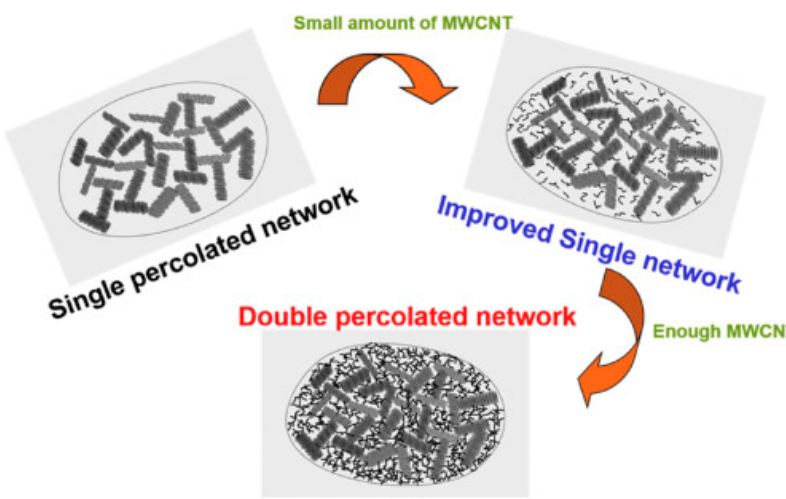
Figure 19. Schematic diagram of dual percolation network constructed by the cooperation of EG and MWCNT in the matrix. Follow the direction of the arrows, MWCNT content inside of the PP/EG-MWCNT ternary composites is increasing [58].